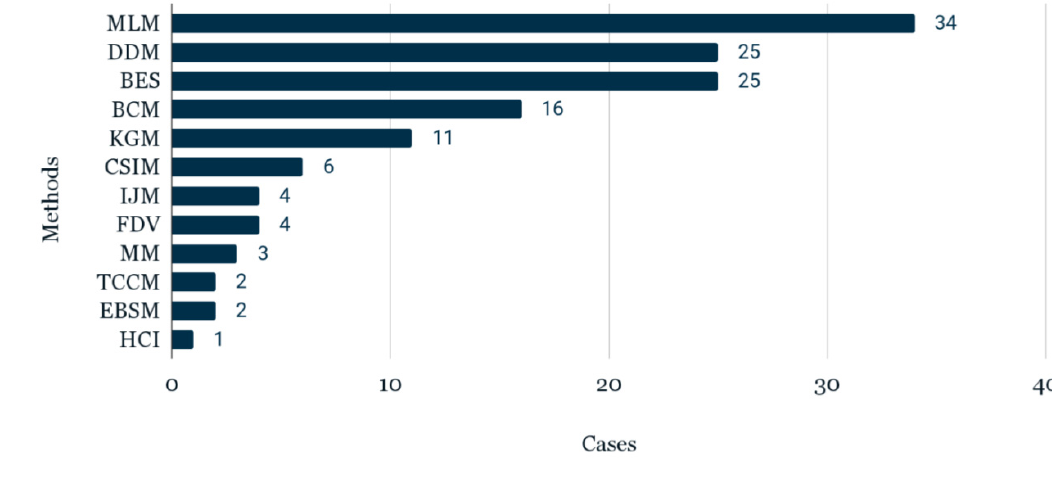
Figure 11. Different methods in CZB. Table 4. Authors working with different CZB methods.